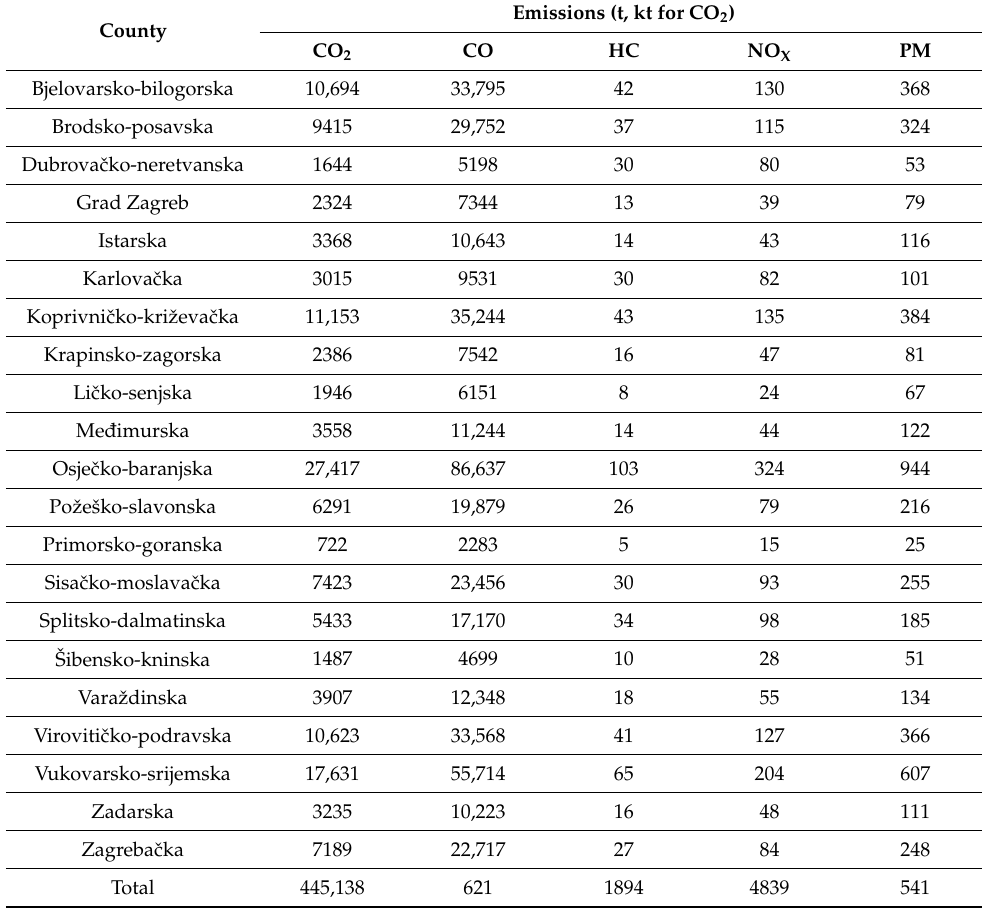
Table A1. Emissions of agricultural machinery by